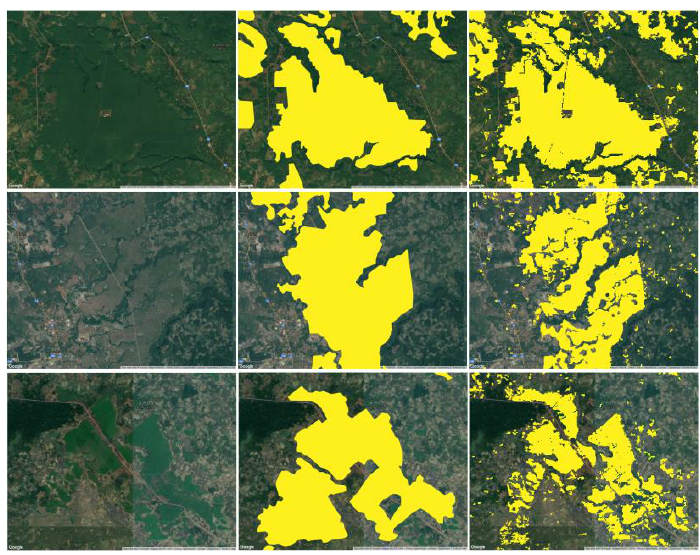
Figure 5. Comparison of hand digitized (center) and classified (right) maps of rubber plantations in southern Laos. The true color background image in the left visually identifies the location of and the nature of plantations.